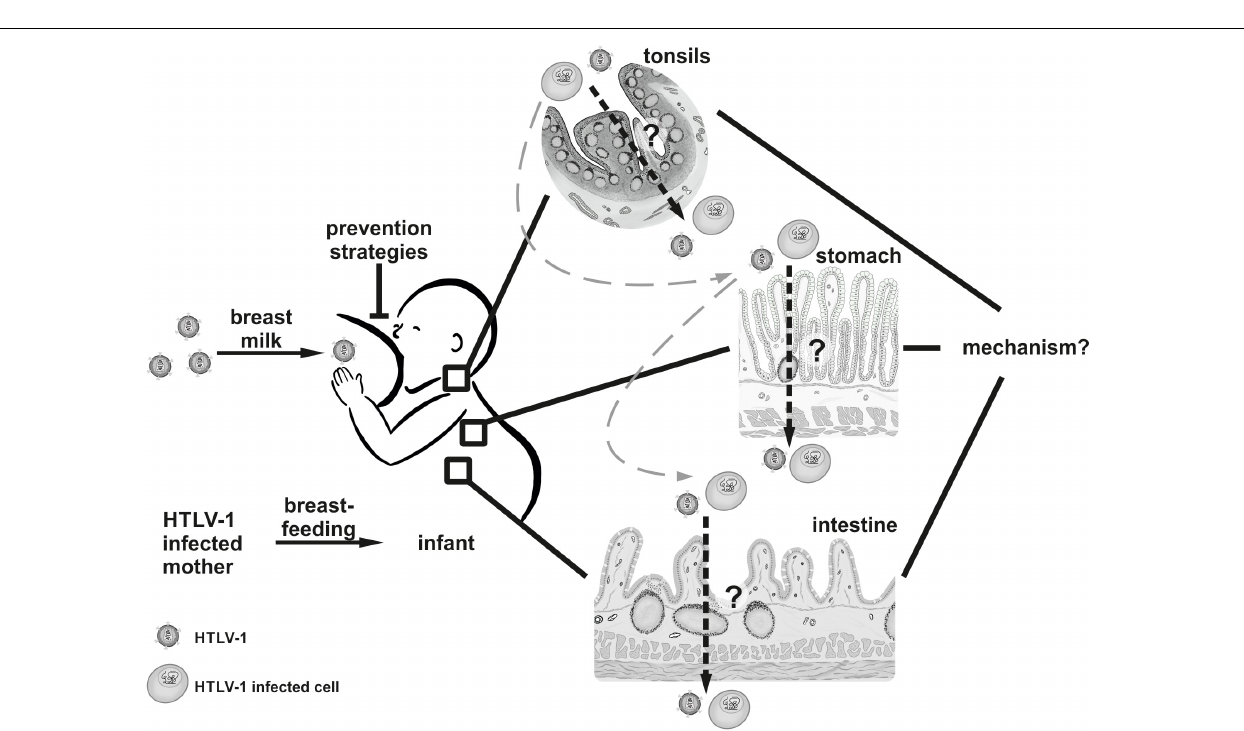
FIGURE 1 | The dilemma of breastfeeding and HTLV-1 transmission. HCMV, Human Cytomegalovirus; HIV, Human Immunodeficiency virus; HTLV, Human T-cell leukemia virus; WHO, World Health Organization. Created with BioRender.